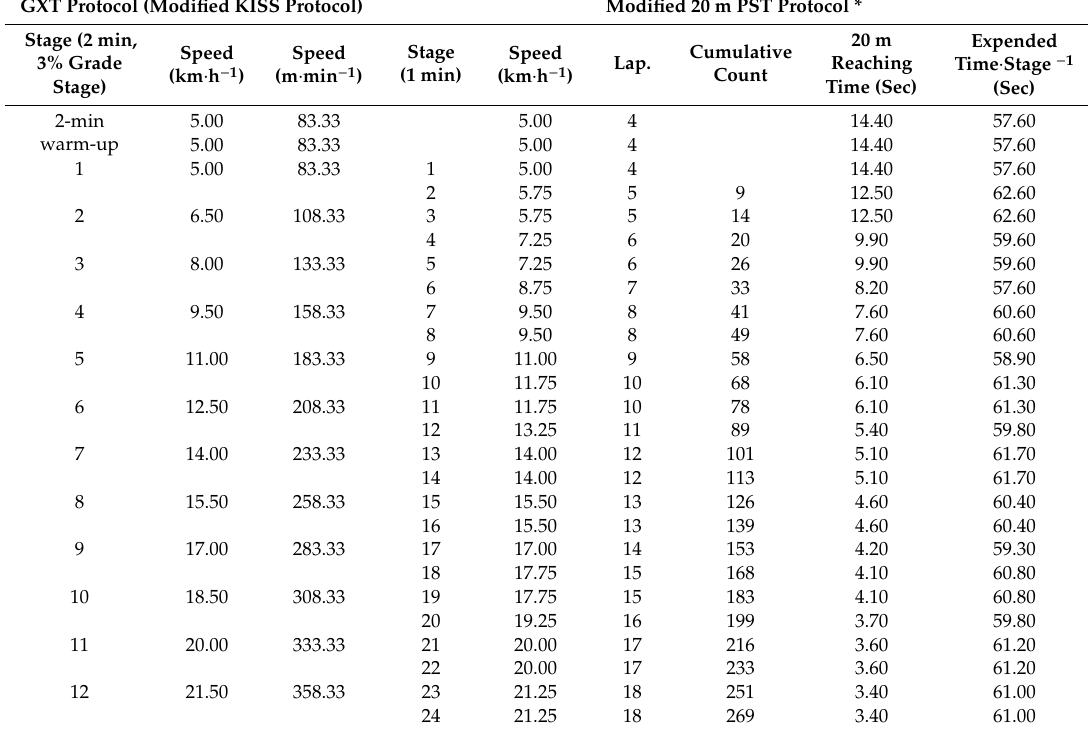
Table 1. The graded exercise test (GXT) and modified 20 m progressive shuttle test (PST) protocols. GXT Protocol (Modified KISS